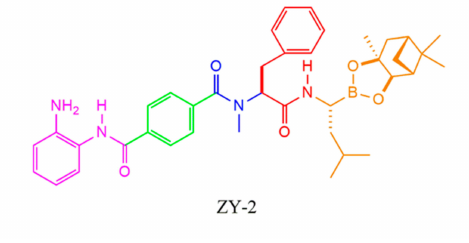
Figure 7. Chemical structure of